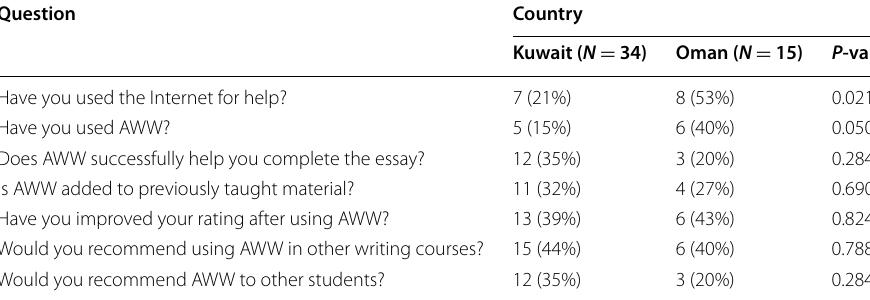
Table 5 Comparisons of binary variables by country Question